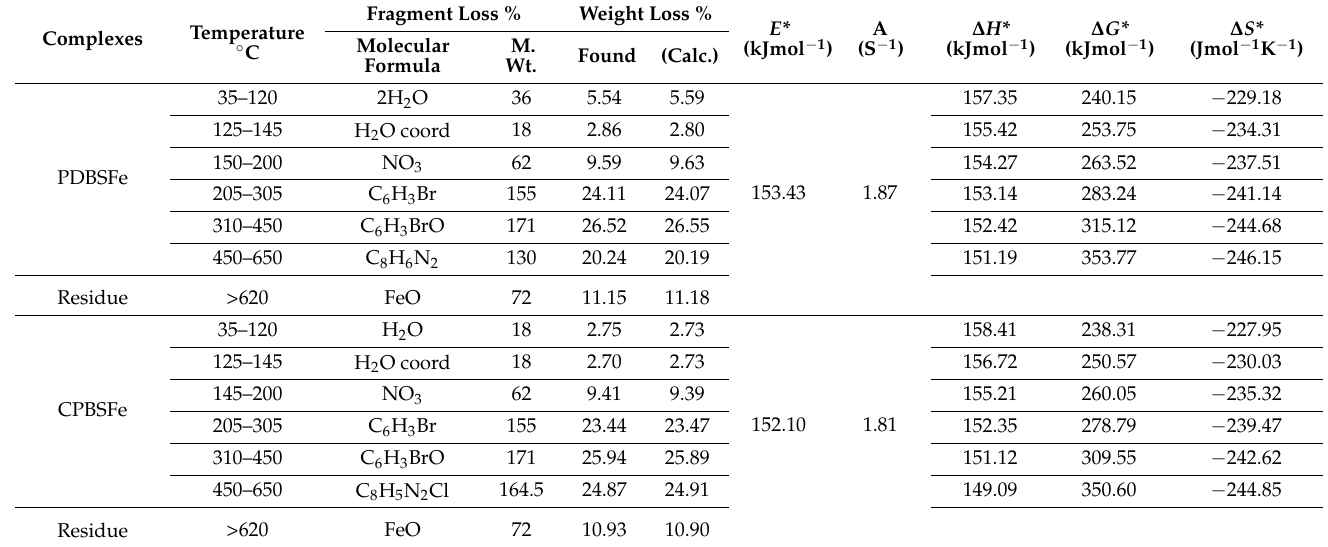
Table 2. The plausible degradation pathway of the complexes; the kinetic and thermodynamic parameters.